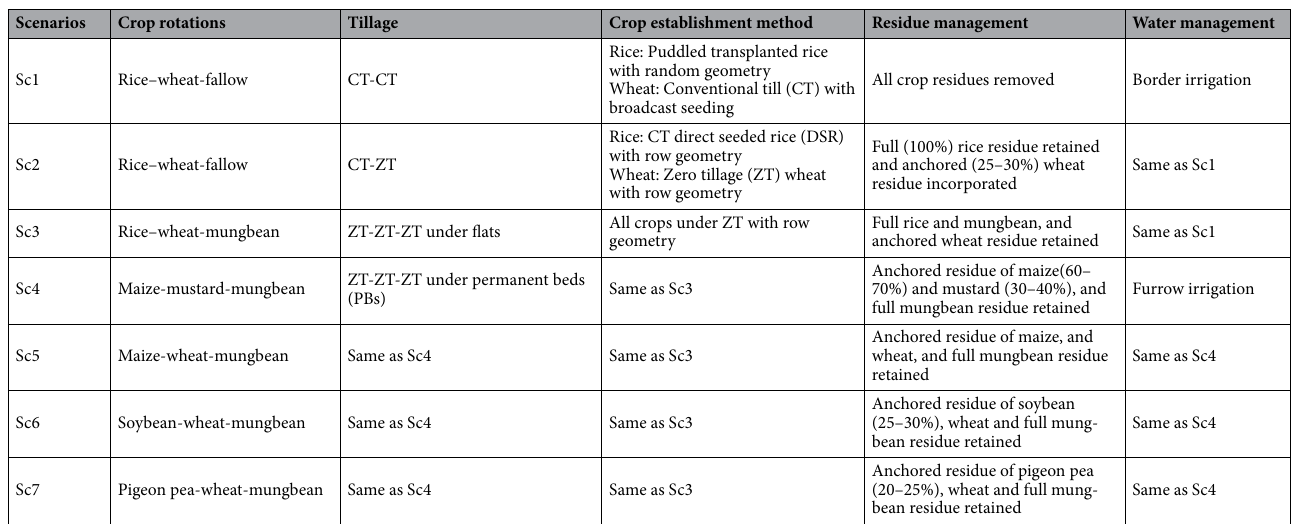
Table 4. Crop rotation, tillage and crop establishment method, residue management and water management protocols under different scenarios. CT conventional tillage, ZT zero tillage, PBs permanent beds, DSR direct seeded